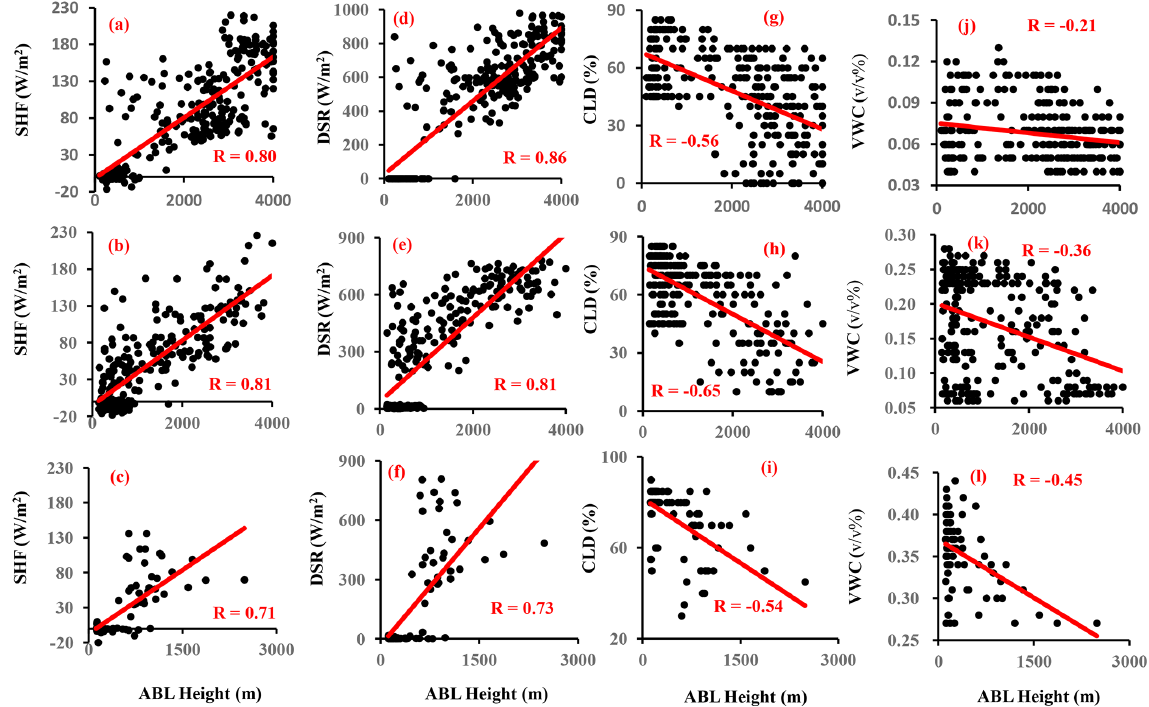
Figure 9. Scatter plots of the ABLH and the 6h average of surface sensible heat flux (SHF) (a–c) , surface downward solar irradiance (DSR) (d–f) , total cloud coverage (CLD) (g–i) , and surface soil volume moisture content (VWC) (j–l) at 08:00, 14:00, and 20:00BJT at